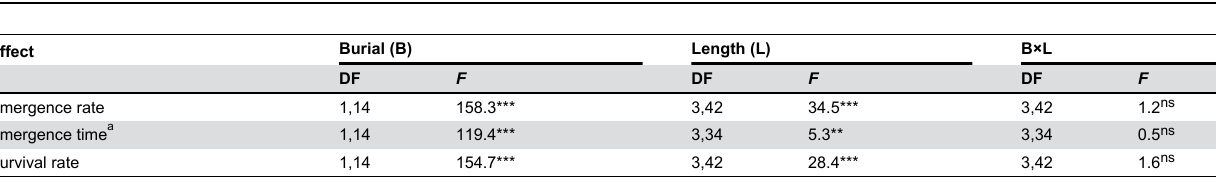
Table 1. Split-plot ANOVAs for effects of burial depth, stolon internode length and the interaction on emergence rate, emergence time and survival rate of Mikania micrantha